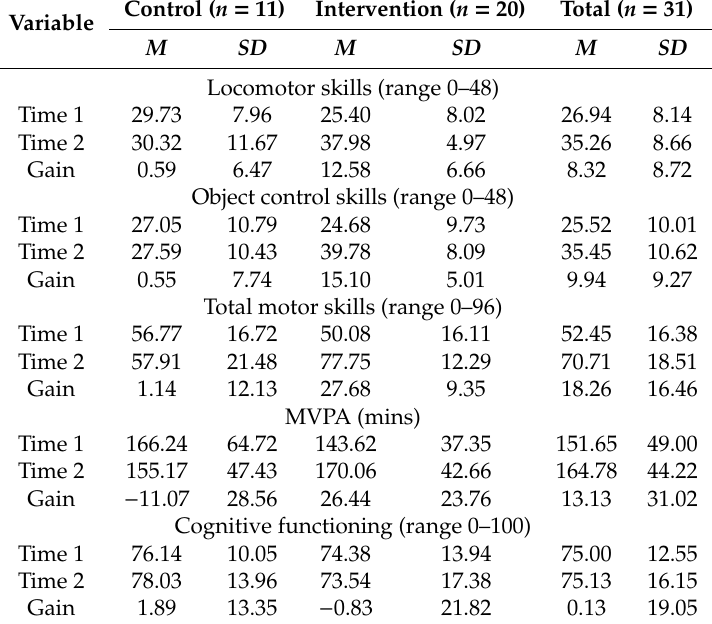
Table 2. Descriptive statistics of fundamental motor skills, MVPA, and cognitive functioning by groups at Time 1 and Time 2.